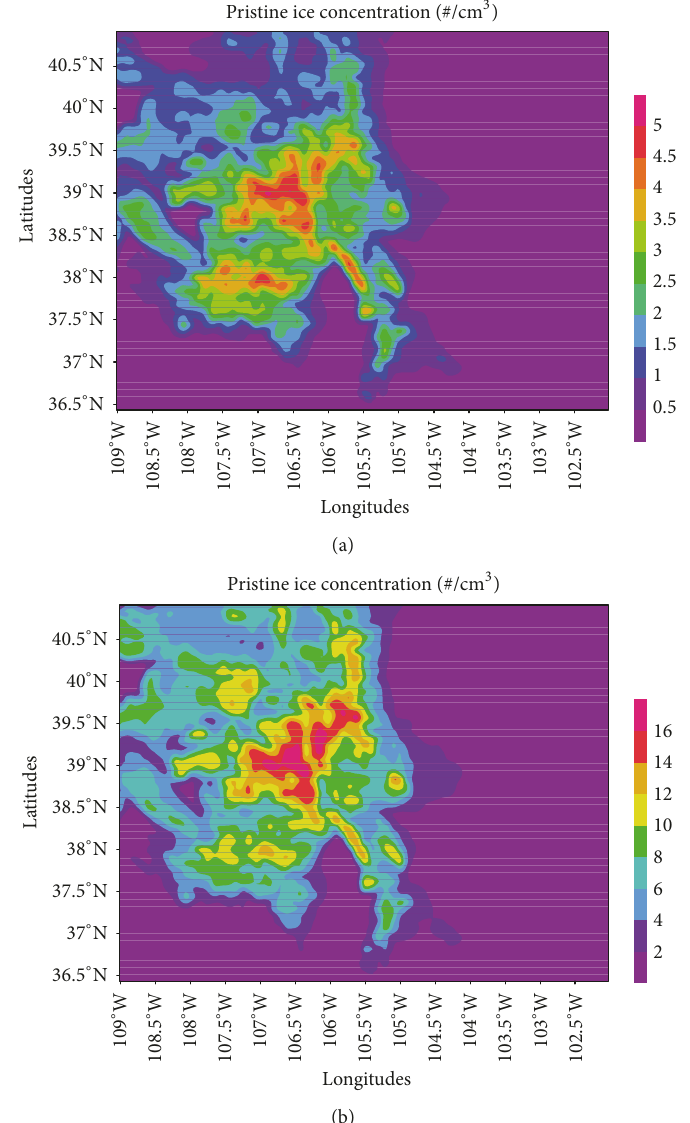
Figure 13: Pristine ice concentration of Case Study 3 for a1d1 (a), a1d10